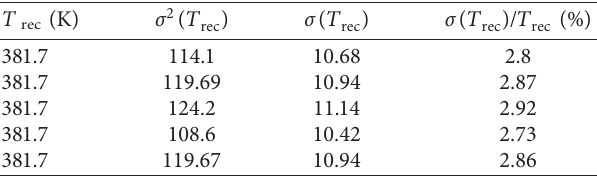
Table 7: Accuracy calculation results of the chopper wheel method at 90 ° .